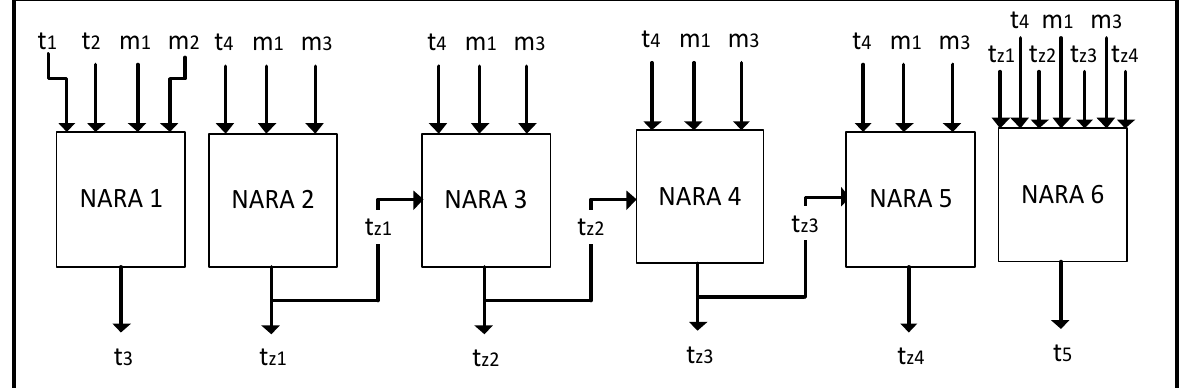
Figure 3. Proposed NARA models. Inputs are temperatures and flow rates. They are in the upper part of the figure ( t points of the hot